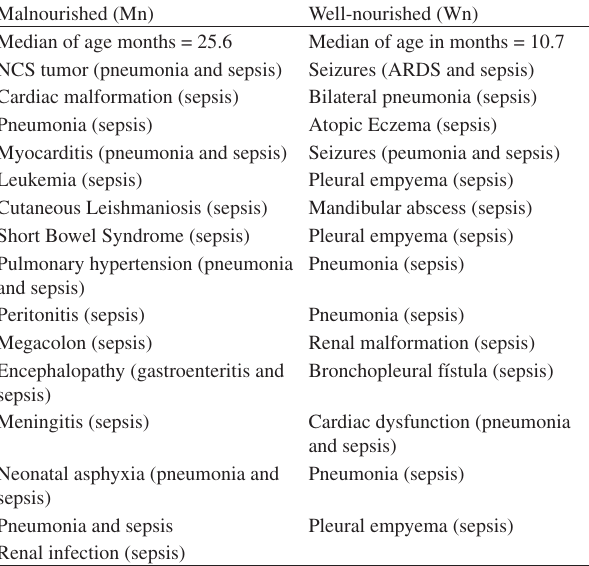
Table 2 - Description of the diagnosis of the 29 selected patients according to age